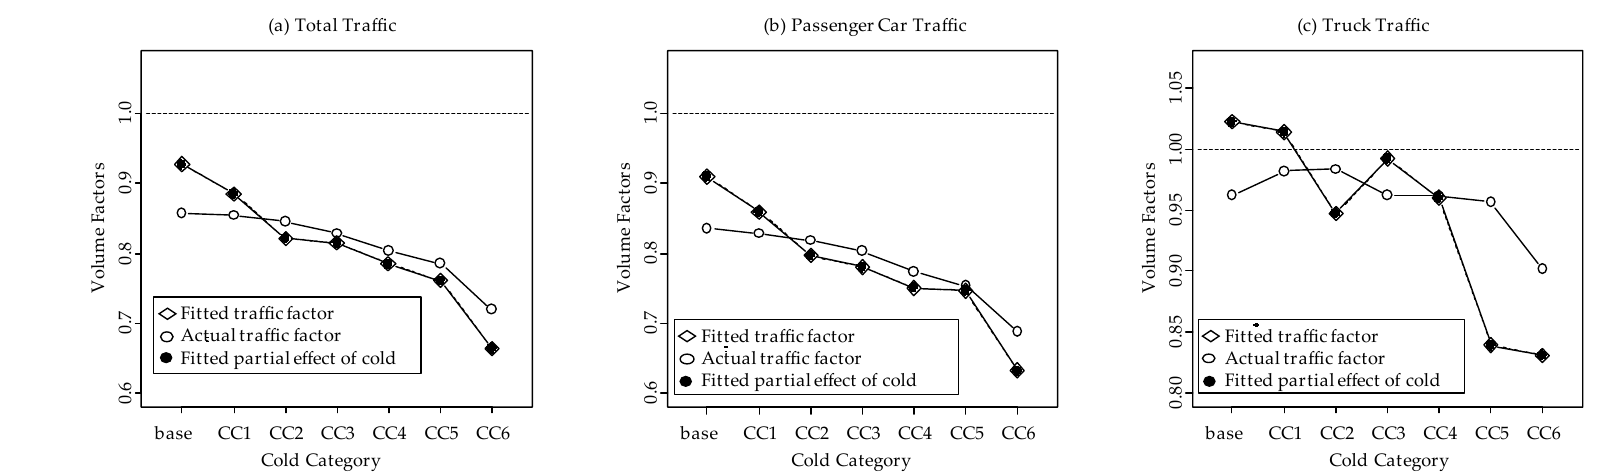
Figure 10. The marginal effect of cold categories on traffic volume factor at Leduc Highway 2.